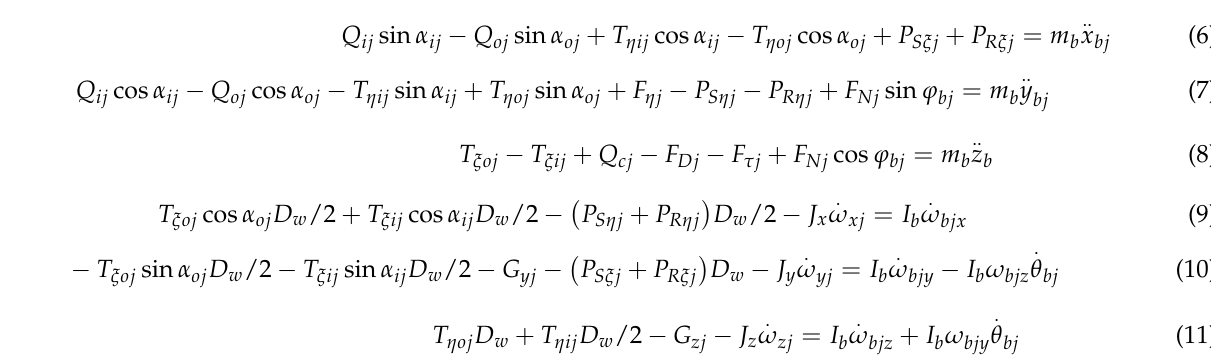
Figure 9. Forces acting on the cage.